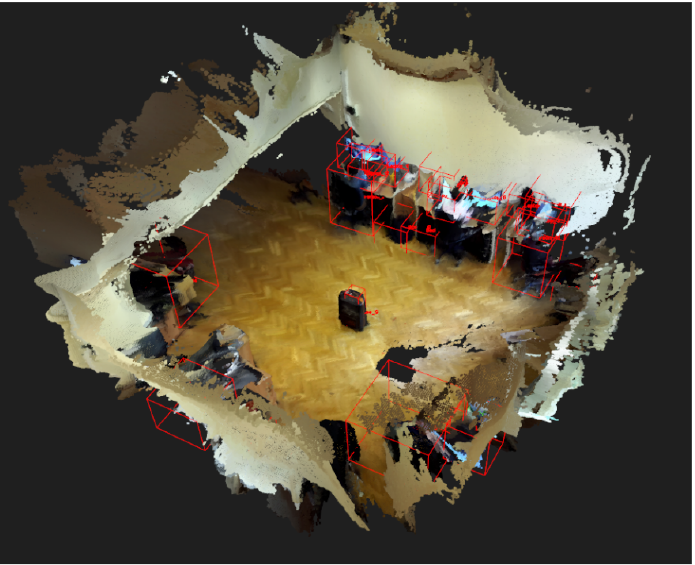
Figure 8. The 3D semantic object map of the SZTAKI office and the suitcase in the middle of it. When the suitcase was at the same location with the same orientation, the algorithm successfully detected no change in the object between the two patrol routes. During the third patrol route in the same office area, the suitcase was moved to various